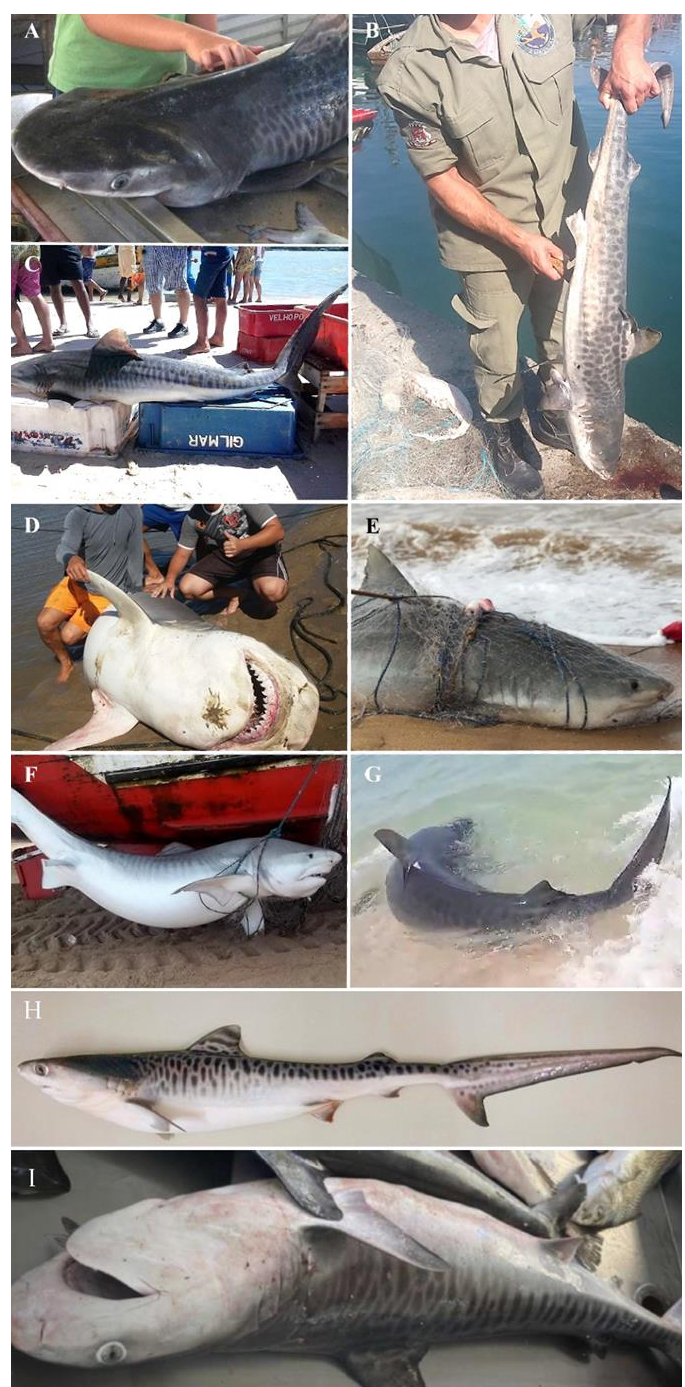
Figure 3. Some of the tiger shark records obtained for the coast of the state of Rio de Janeiro. Photos: ( A ) — Copacabana Beach (2013), ( B ) — Arraial do Cabo (2018), ( C ) — Cabo Frio (2013), ( D ) — Campos dos Goytacazes (2016), ( E ) — São João da Barra (2020), ( F ) — Campos dos Goytacazes (2021), ( G ) — Saquarema (2022), ( H ) — Copacabana Beach (2018), ( I ) — Copacabana Beach (2022).